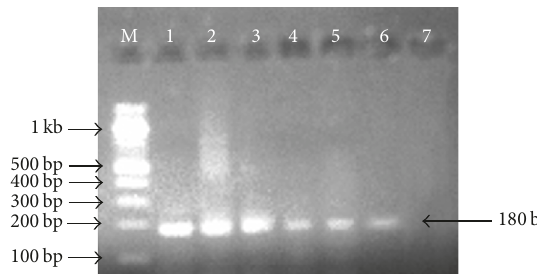
Figure 1: Agarose gel electrophoresis result for PCR detection of Stx1 gene in Escherichia coli O157:H7. Lane M: 100 bp ladder (BioLabs), lane 1: positive control, lanes 2 to 6: positive samples, and lane 7: negative control.